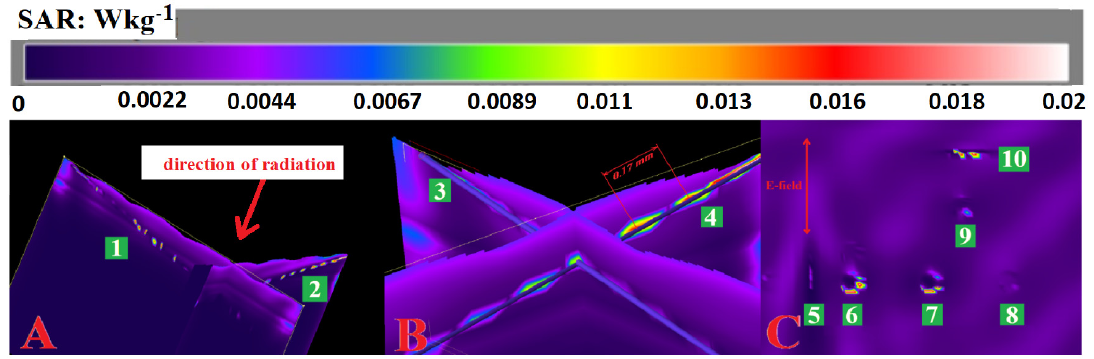
Figure 7. Simulations of SAR surrounding “unwound” sweat ducts in thick skin. ( A ) Unwound duct, with E-field polarization shown. ( B ) Detail of unwound sweat ducts. The SAR pattern suggests that there are standing waves within and surrounding the duct (1–4). The waves of ~0.17 mm (~ λ /2) are situated within, above and below the duct when the duct is running parallel to the E-field direction and are lateral to the duct when the duct is perpendicular to the incident E-field. ( C ) Horizontal cutplane detail of ducts in the middle of the Stratum Corneum, E-field direction shown, (5) unwound duct, parallel, (6) helical sweat duct containing 10,014 Sm − 1 sweat, insulating layer surrounding duct, (7) no insulating layer, (8) helical sweat duct “physiological” sweat, (9) helical sweat duct 1001 Sm − 1 sweat, (10) unwound duct, perpendicular.